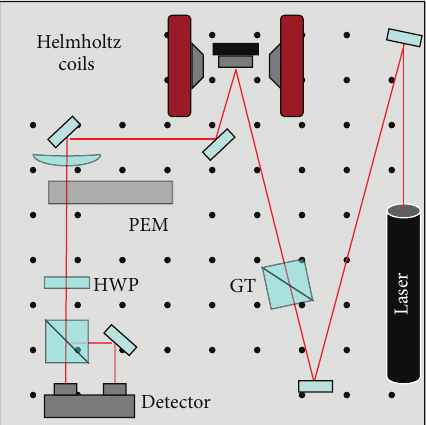
Figure1:MOKEset-up:GT:Glan-Thompsonpolarizer;HWP:half- wave plate; PEM: photoelastic